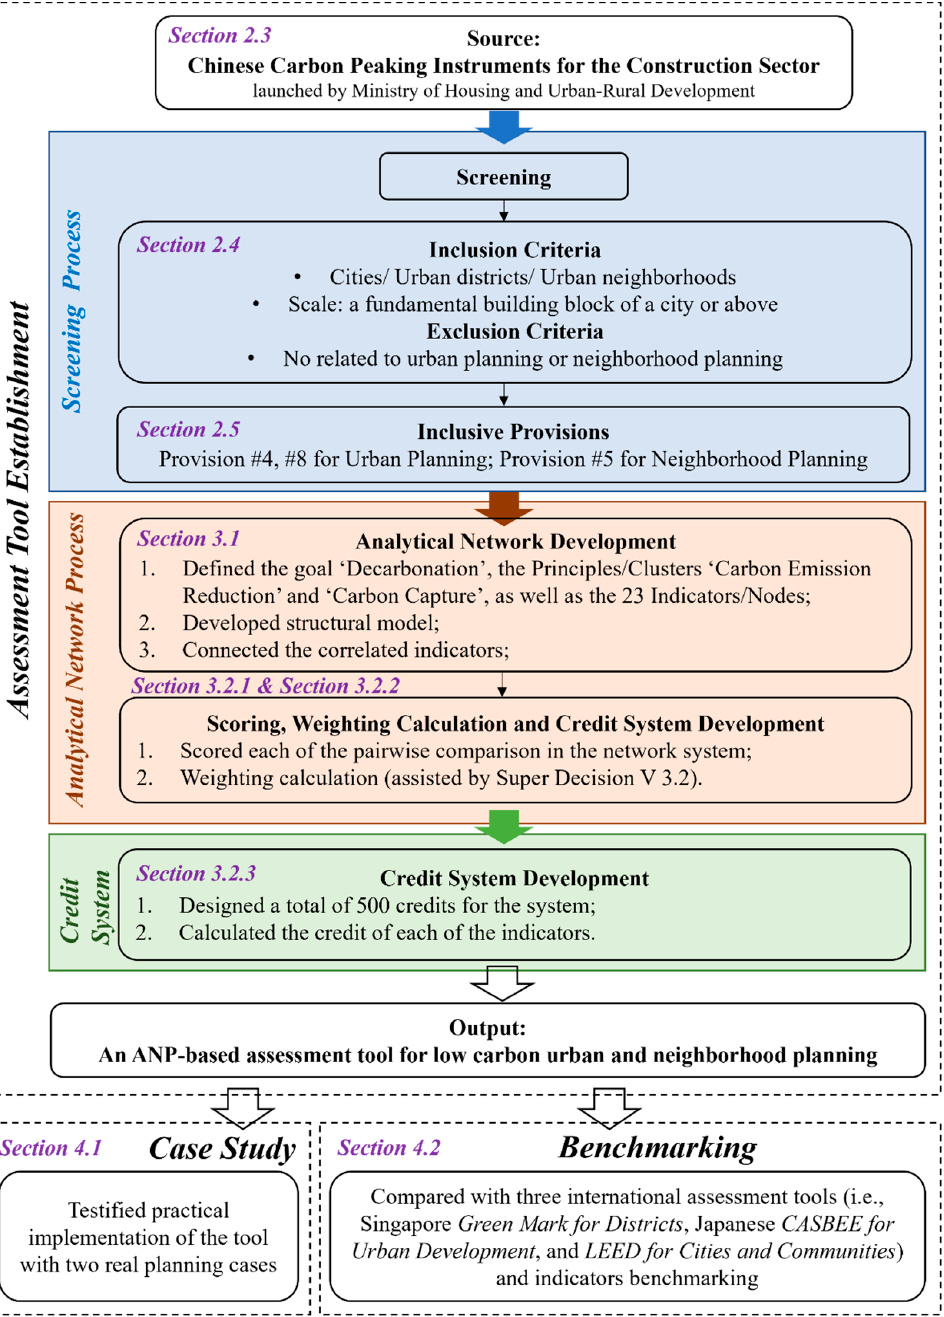
Figure 3. Flowchart for this study.